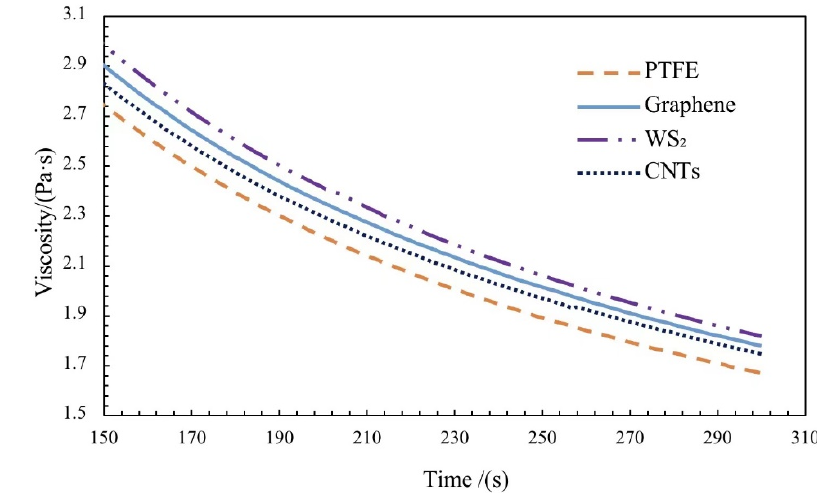
Figure 11. Change of apparent viscosity of grease with time under shear condition.